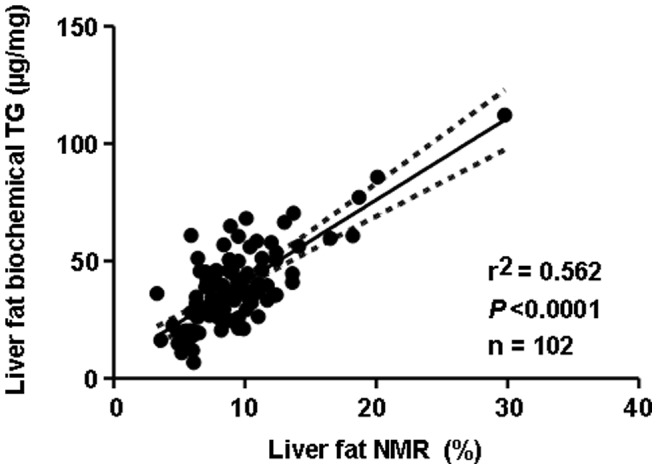
Correlation of liver triglyceride content detected with enzymatic assays and relative liver lipid content measured with magnetic resonance spectroscopy.